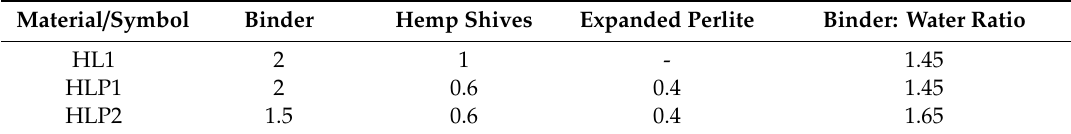
Table 2. Mixture proportions (by weight).